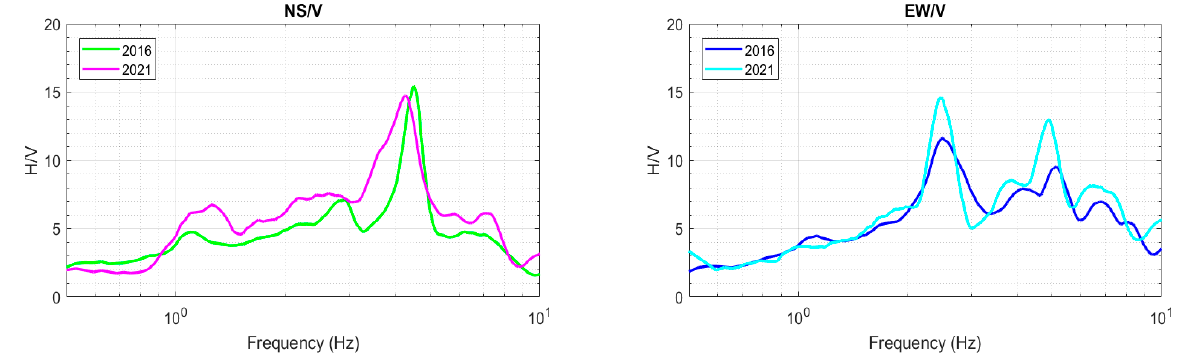
Figure 6. Comparison between ambient noise measurements carried out in 2016 and 2021 on the top of the Castle’s tower.